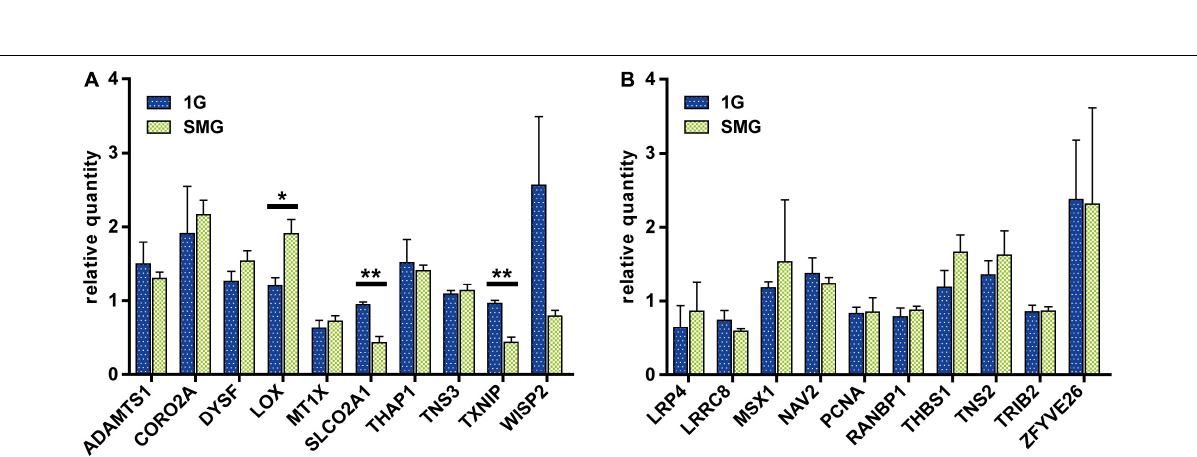
Frontiers in Cell and Developmental Biology |